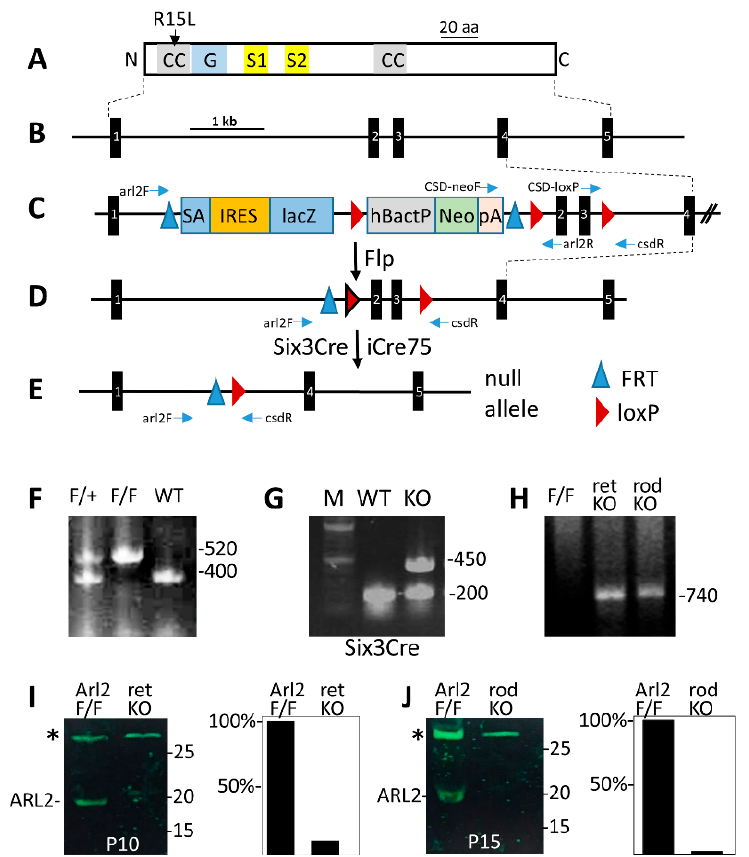
Figure 1. Generation of Arl2 conditional knockouts. ( A ) schematic of mouse ARL2 protein and its functional domains. CC, coiled coil domain; G, guanine nucleotide binding domain; S1 and S2, switch 1 and switch 2; R15L, mutation linked to retina disease. ( B ) the mouse Arl2 gene with 5 exons. ( C ) the gene trap is located in intron 1. The gene trap is flanked by FRT sites. LoxP sites are flanking the NEO cassette and a third loxP site is placed in intron 3. Horizontal blue arrows delineate approximate positions of genotyping primers. ( D ) floxed allele. ( E ) null allele. ( F ) genotyping floxed allele in tail DNA with arl2-F and arl2-R yielding a WT amplicon of 520 bp and a floxed amplicon of 400 bp. ( G ) presence of Six3Cre in tail DNA using Six3Cre–F and Six3Cre–R yielding an amplicon of 450 bp. The bands of 200 bp are an internal positive control (see Methods). ( H ) genotyping the Six3Cre (ret) and iCre65 (rod) knockout allele with CSDF and CSDR using retina DNA as a template. The diagnostic fragment of 740 bp is absent in Arl2 F/F . ( I , J ) Western blots (left panels) with anti-ARL2 antibody using P10 ret Arl2 − / − retina lysate ( I ) and P15 rod Arl2 − / − retina lysate ( J ). Polypeptides marked with asterisks are nonspecific polypeptides serving as loading controls. ( I , J ) right panels are Image J density scans of